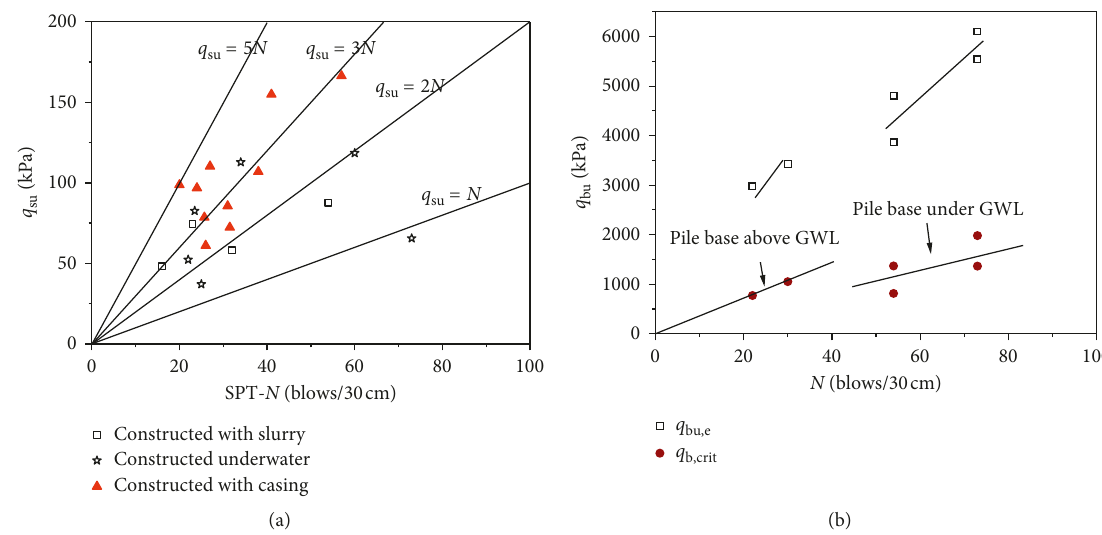
Figure 10: Relationship between SPT- N and the ultimate unit shaft resistance ( q residual soil of all piles. (a) q su versus N . (b) q bu versus N .